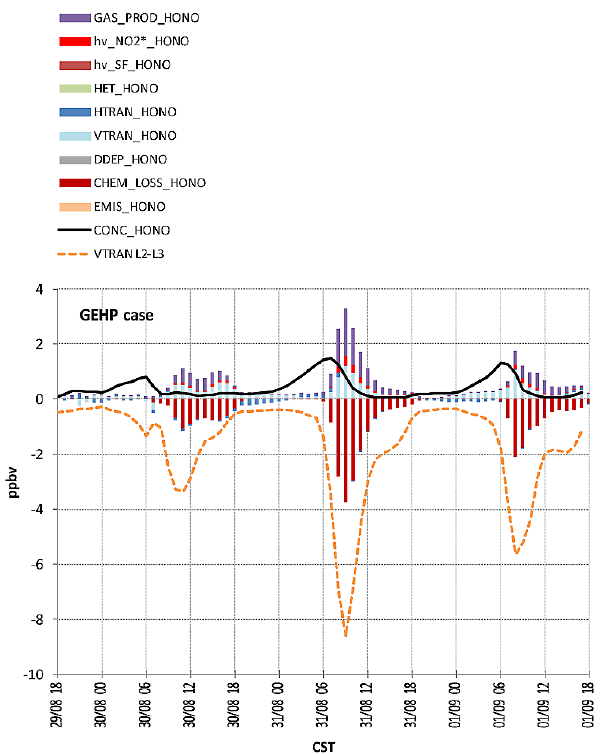
Fig. 10. The same as Fig. 9 but for the model layer 2, which is between 34–85ma.g.l. “VTRAN L2–L3” represents HONO trans- ported upward from layer 2 to the next model